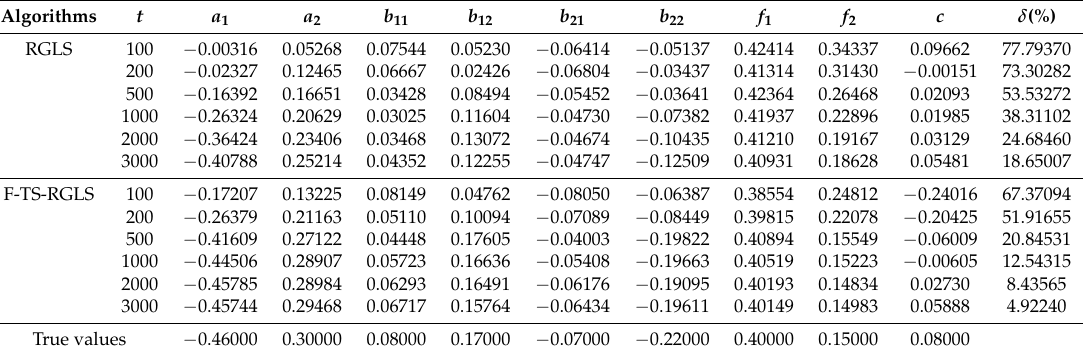
Table 2. The parameter estimates and their errors with σ 2 = 0.15 2 .